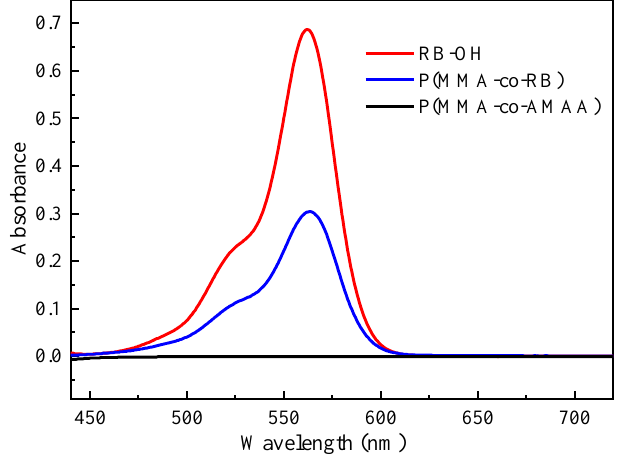
Figure 2. Absorption spectra of P(MMA-co-AMAA) (0.5 mg/mL), RB-OH (0.05 mg/mL) and P(MMA-co-RB) (0.5 mg/mL) in DMF solution.